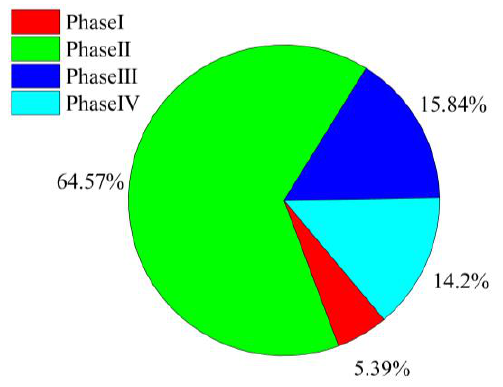
Figure 3. Percentage of settlement composition at each stage.